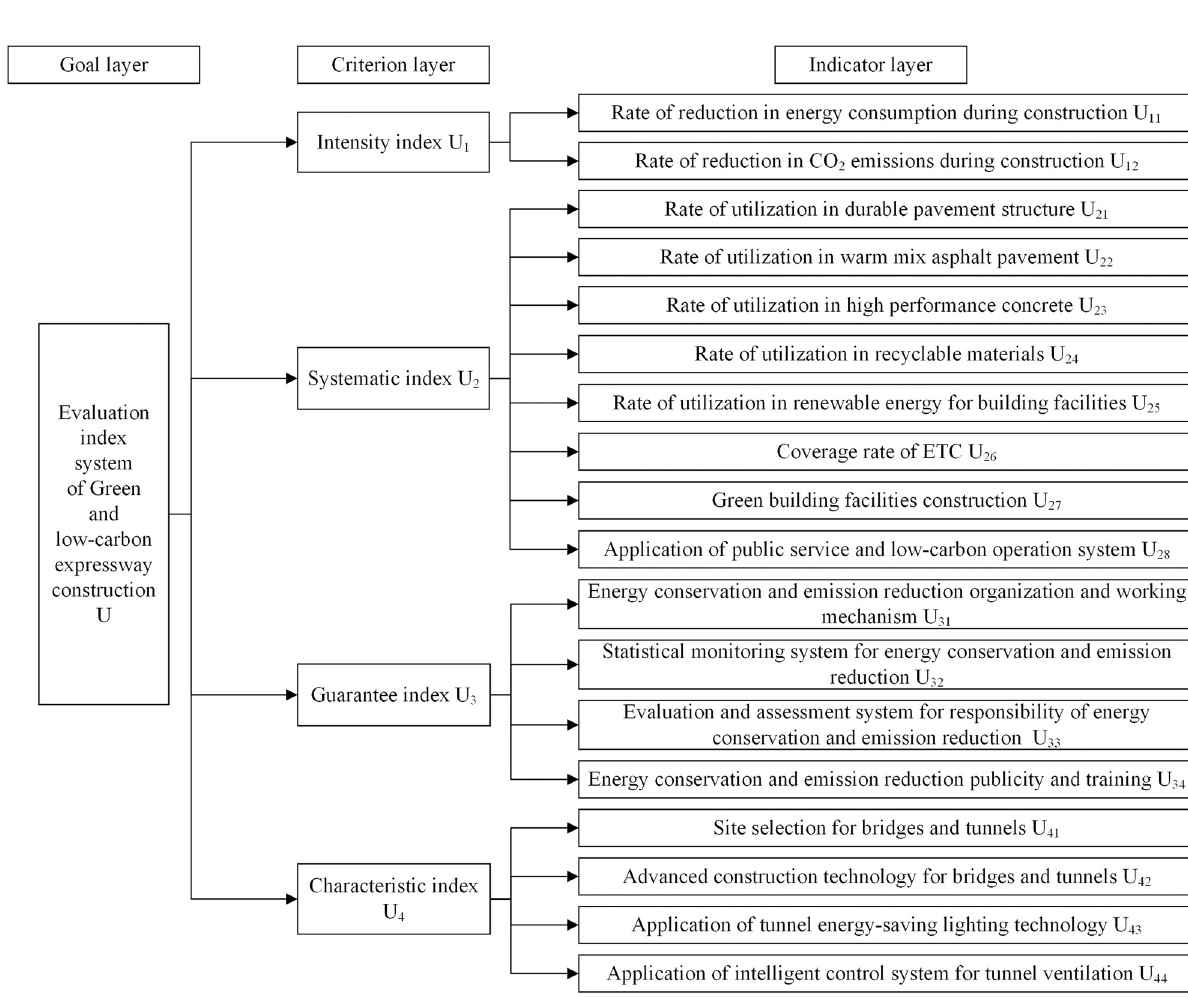
Fig 1. The proposed green and low-carbon expressway construction evaluation index